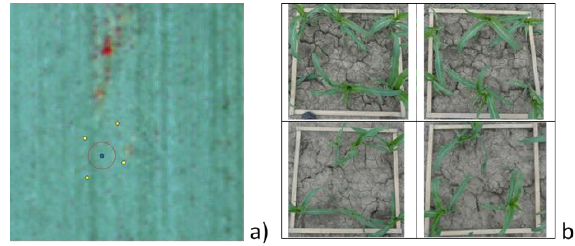
Figure 3. a) Example of in situ measurement of FVC by taking four photos (yellow dots) at each ESU identified by the central coordinates (blu square); b) photo taken at one ESU with reference wooden frame.